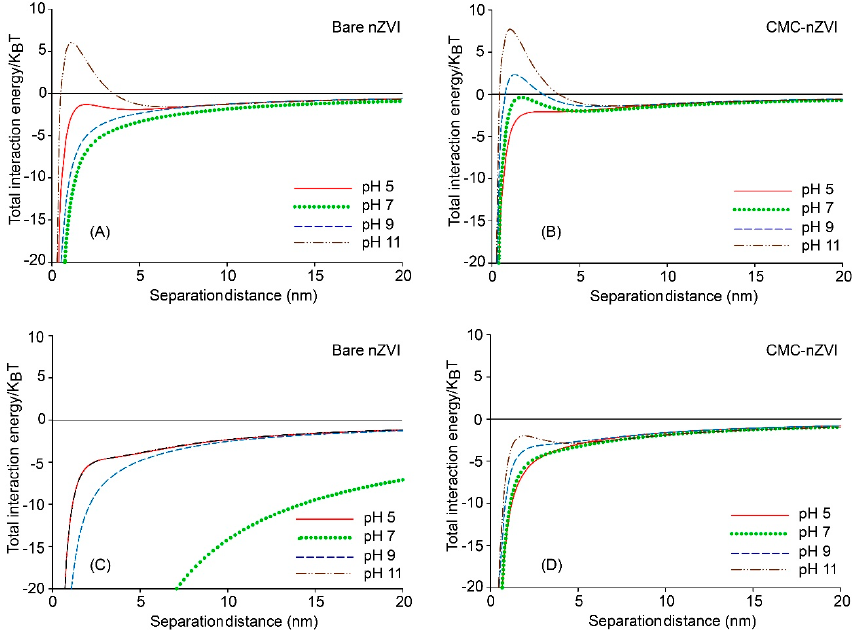
Figure 8. Effect of pH and CMC polymer stabilizer on the total interaction energy of 0.1 g L − 1 (A,B) and 1.0 g L − 1 (C,D) nZVI particle suspensions in 50 mM NaHCO 3 .